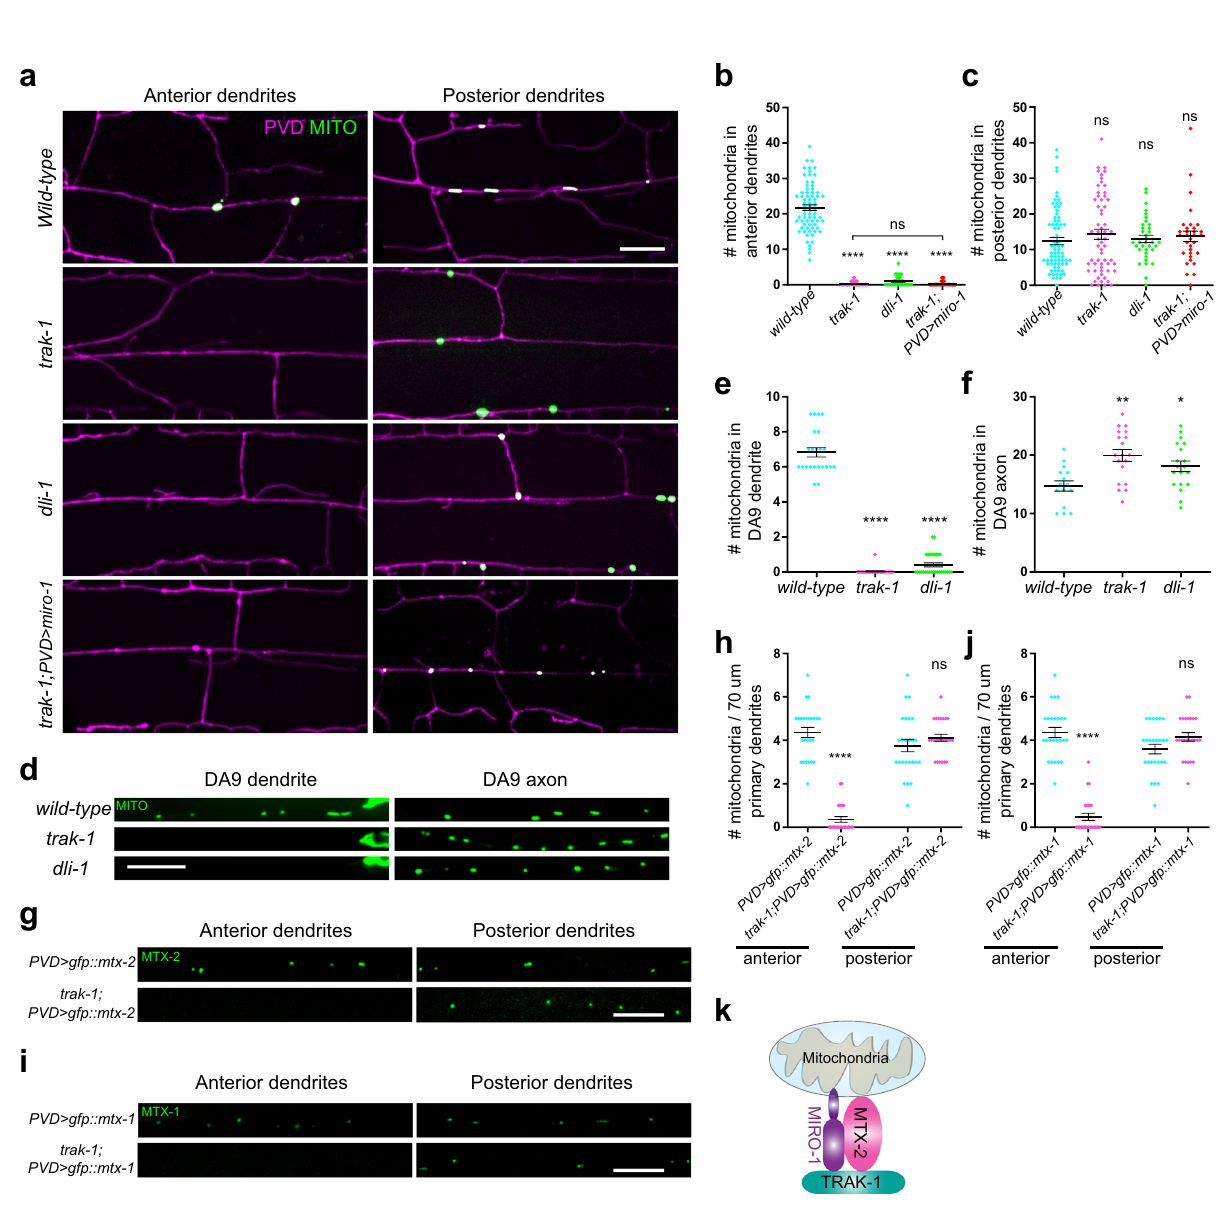
NATURE COMMUNICATIONS| (2021) 12:83